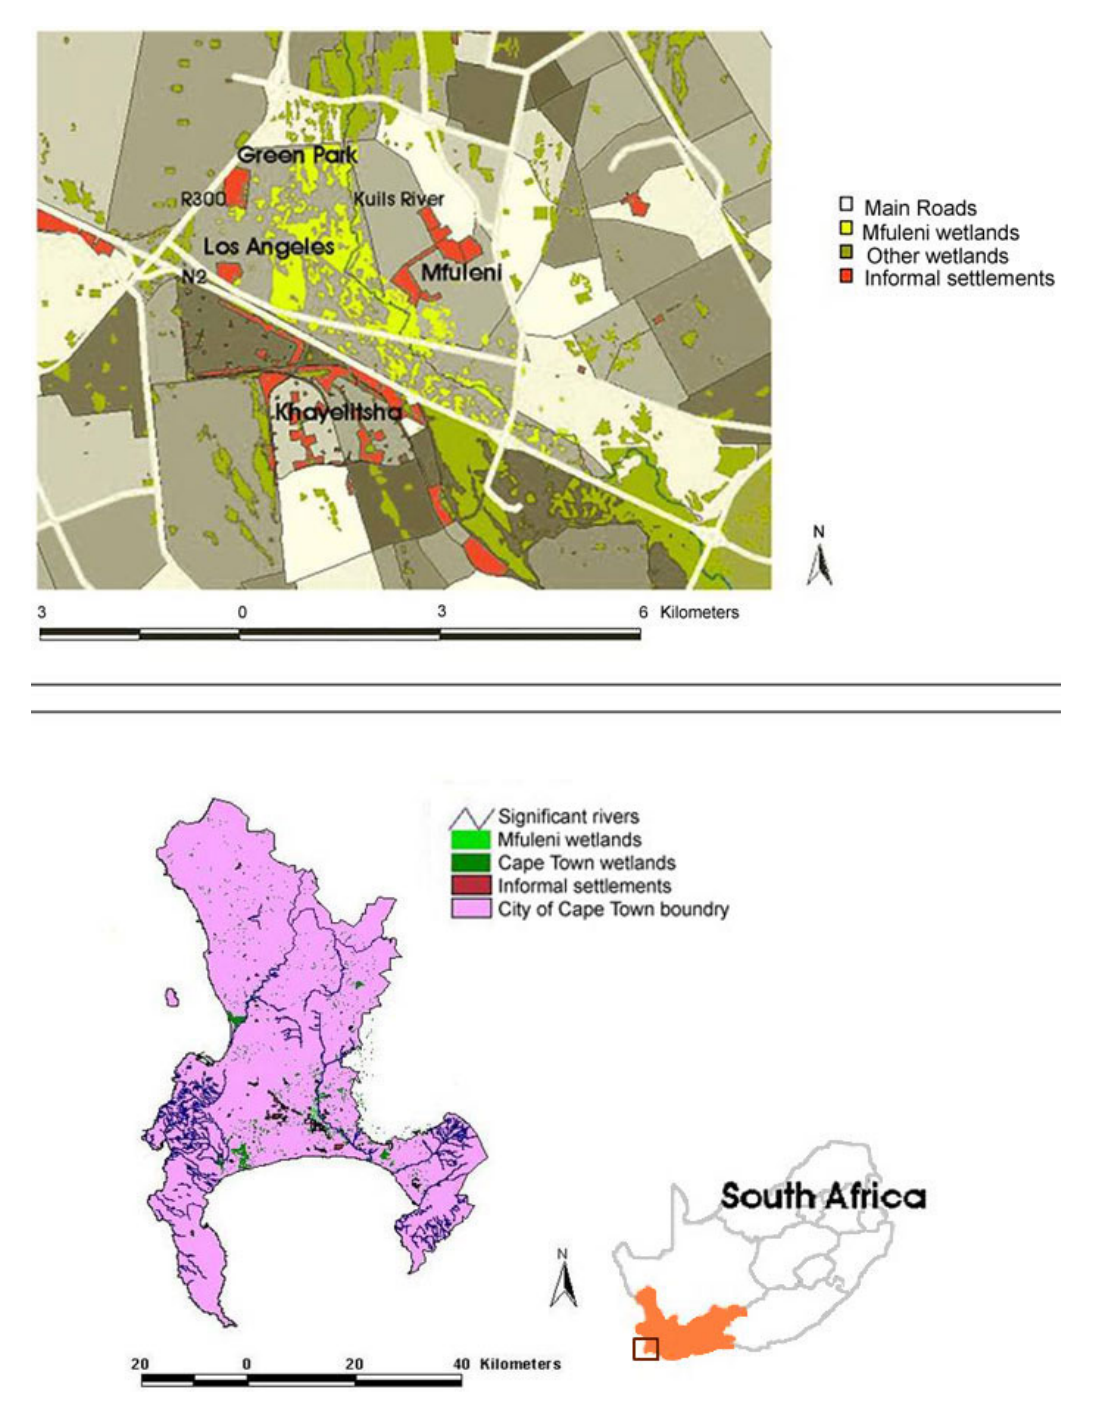
Fig. 2 . Location of wetlands around the township of Mfuleni in Cape